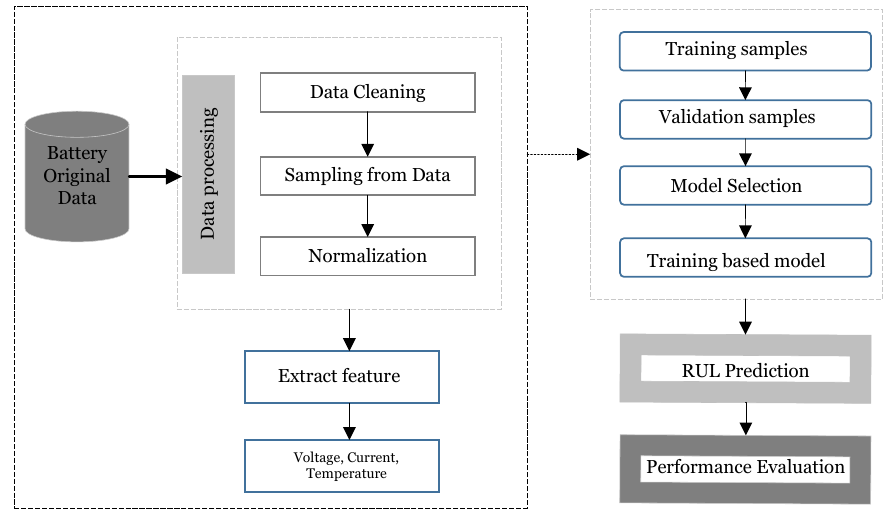
Figure 2. RUL prediction framework based on the proposed method for lithium-ion